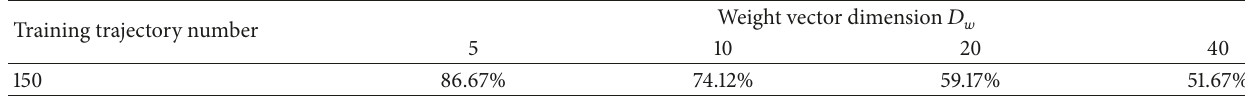
Table 4: Recognition accuracy with different number of 𝐷 𝑤 .